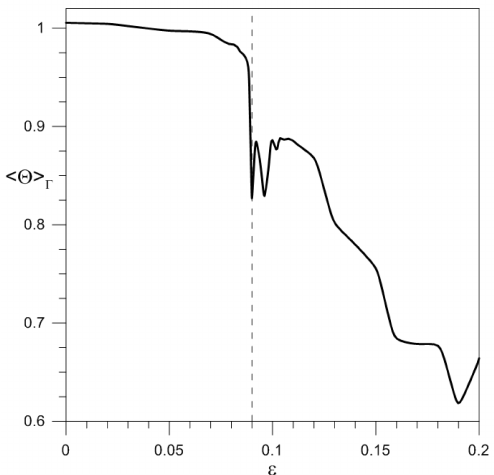
Figure 13. Transition from periodic to chaotic behavior, illustrated by the metric (cid:104) (cid:50) (cid:105) (cid:48) plotted vs. the amplitude ε of the periodic forc- ing in Eq. (3); γ = 1 . 1 and T p = 30 years.